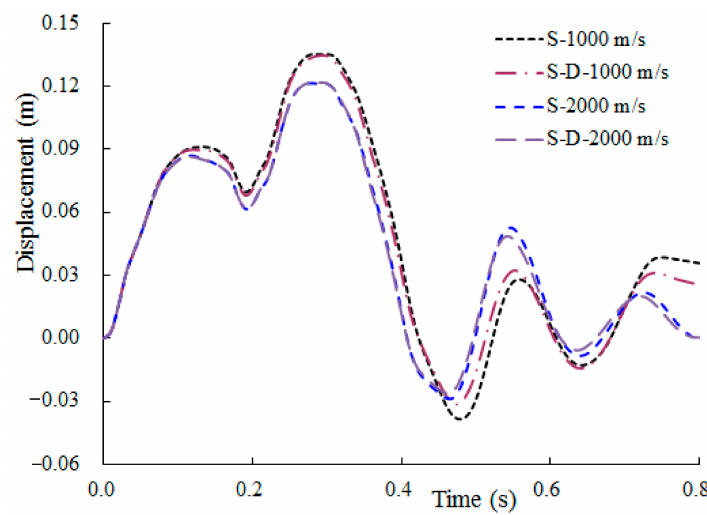
Figure 19. Max displacement time-histories of containment.